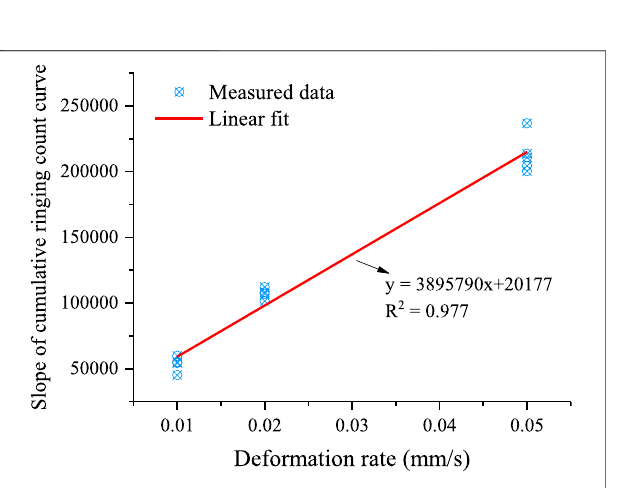
curve is approximated as the slope of the cumulative ring down count curve by linear fi tting of the cumulative ring down count curve with time. With the deformation rate of 0.05 mm/s, the